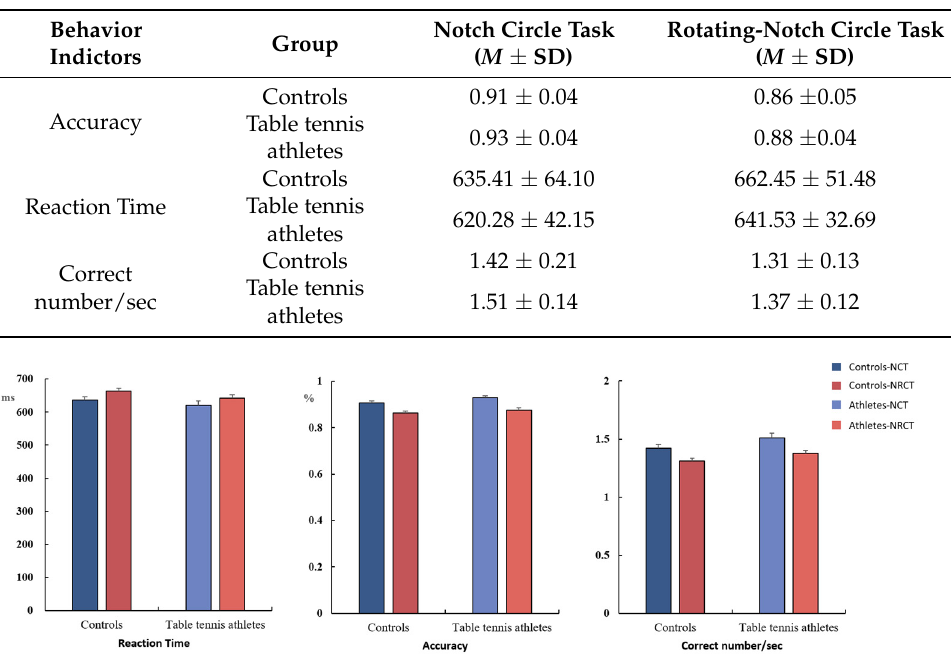
Figure 3. Reaction time, accuracy, and number of correct responses per unit time (mean ± standard deviation). NCT: notch circle task; RNCT: rotating-notch circle task.